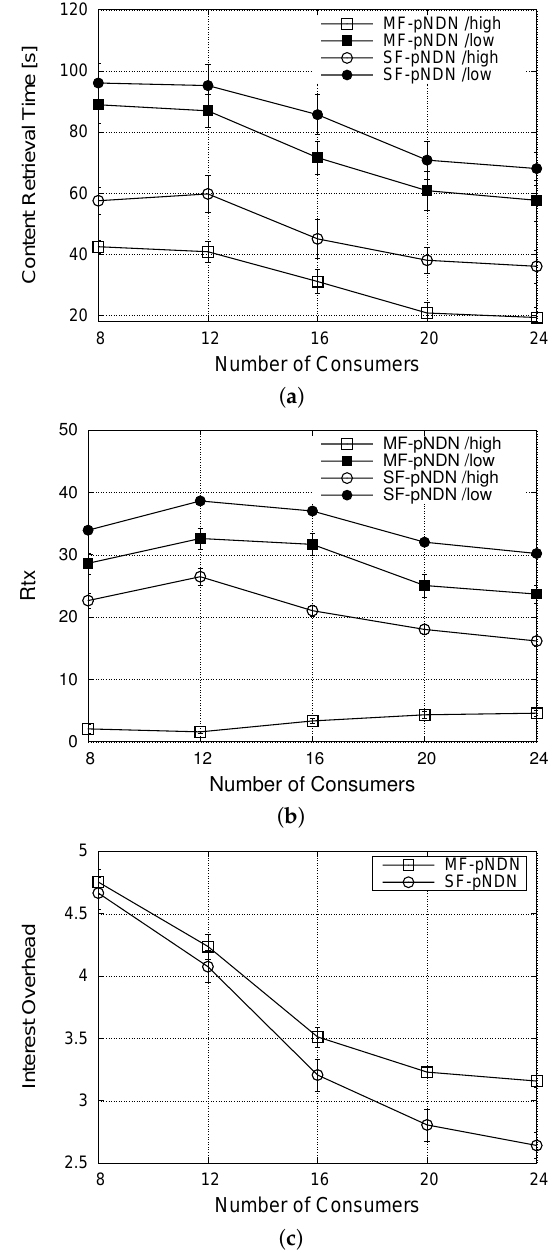
Figure 8. Metrics vs. the number of consumers for the prioritized NDN schemes. ( a ) Content retrieval time; ( b ) Interest retransmissions; ( c ) Interest